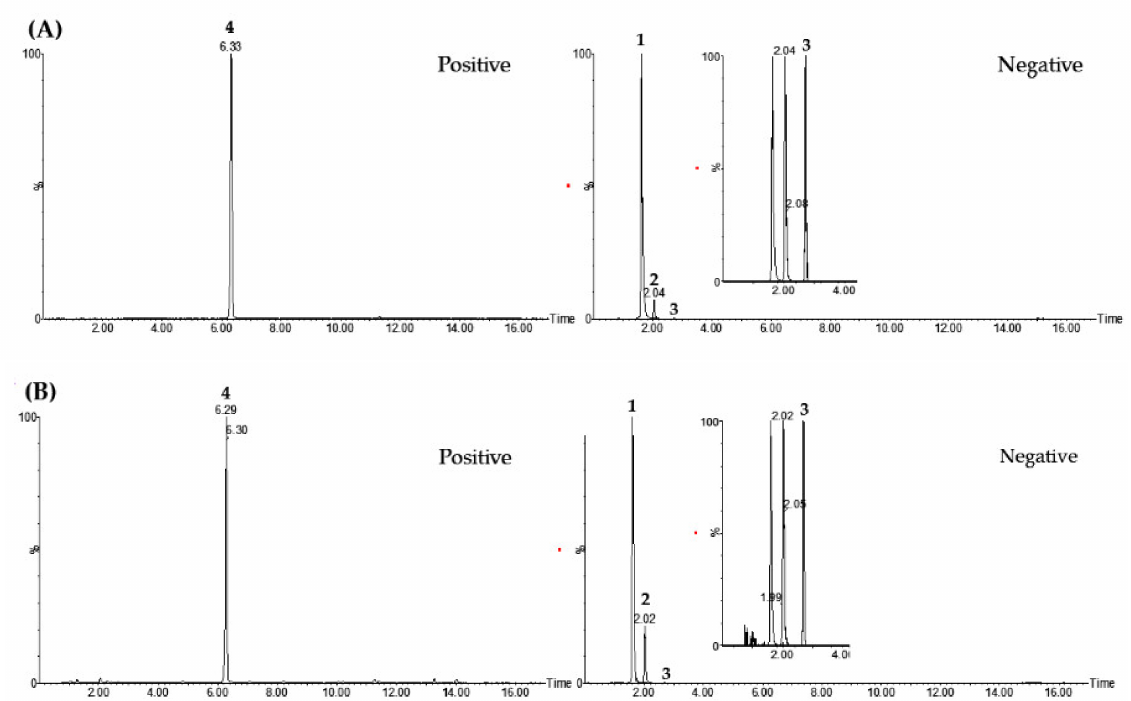
Figure 2. Total ion chromatograms of the standard solution ( A ) and DGJT sample ( B ) by LC–MS/MS MRM method. Hyperoside ( 1 ), quercitrin ( 2 ), ginsenoside Rg1 ( 3 ), and 6-gingerol ( 4